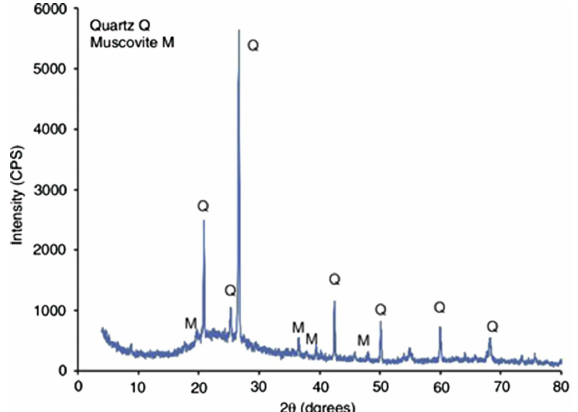
ing materials, which can achieve the purpose of sustainable development. Bakharev [13, 14] found that geopolymer con- crete has strong acid and sulfate resistance. The chloride ion permeability of OPC and GPC was studied by Rajamane and other scholars [15]. Sathia et al. [16] studied the resis- tance and absorption properties of GPC to acids, and he found that this property could improve its durability. In this paper, the mechanism and research progress regarding the carbonation resistance, structural fire resis- tance,corrosionresistance,permeationpropertiesandfrost resistance of geopolymer concretes are reviewed, and the main problems with the durability of geopolymer concretes are